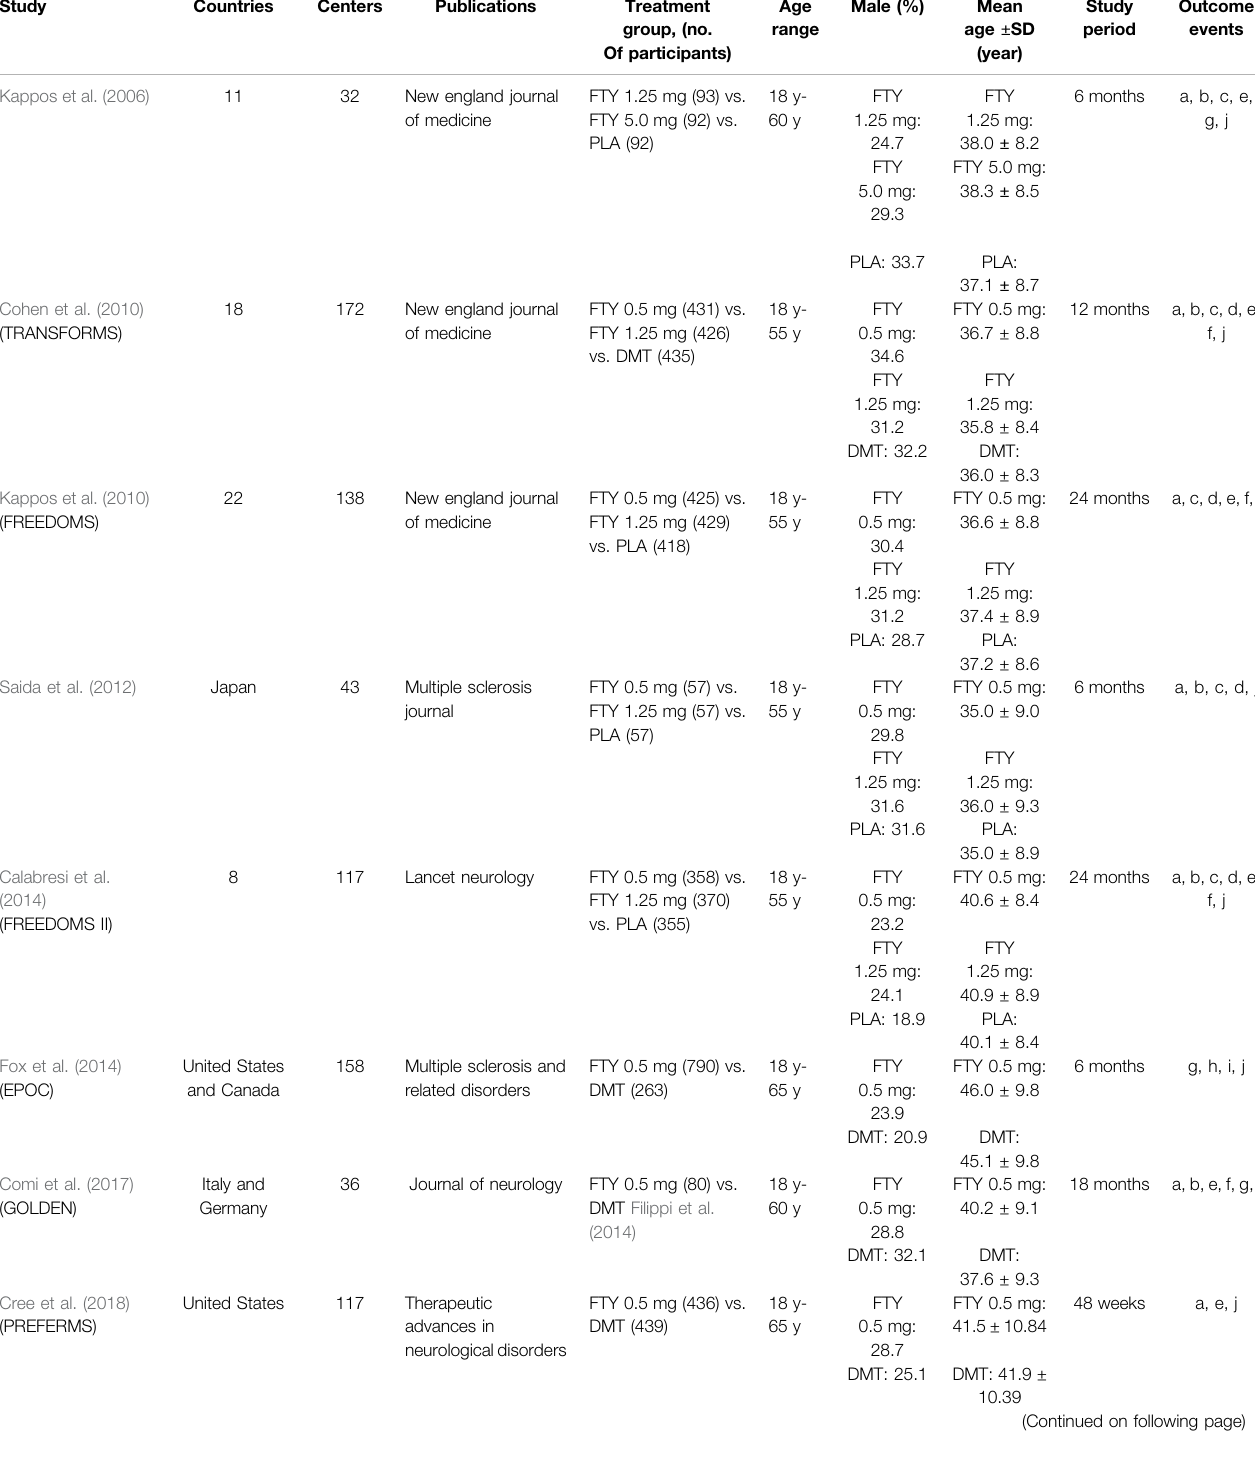
TABLE 1 | Characteristics of the included studies and outcome